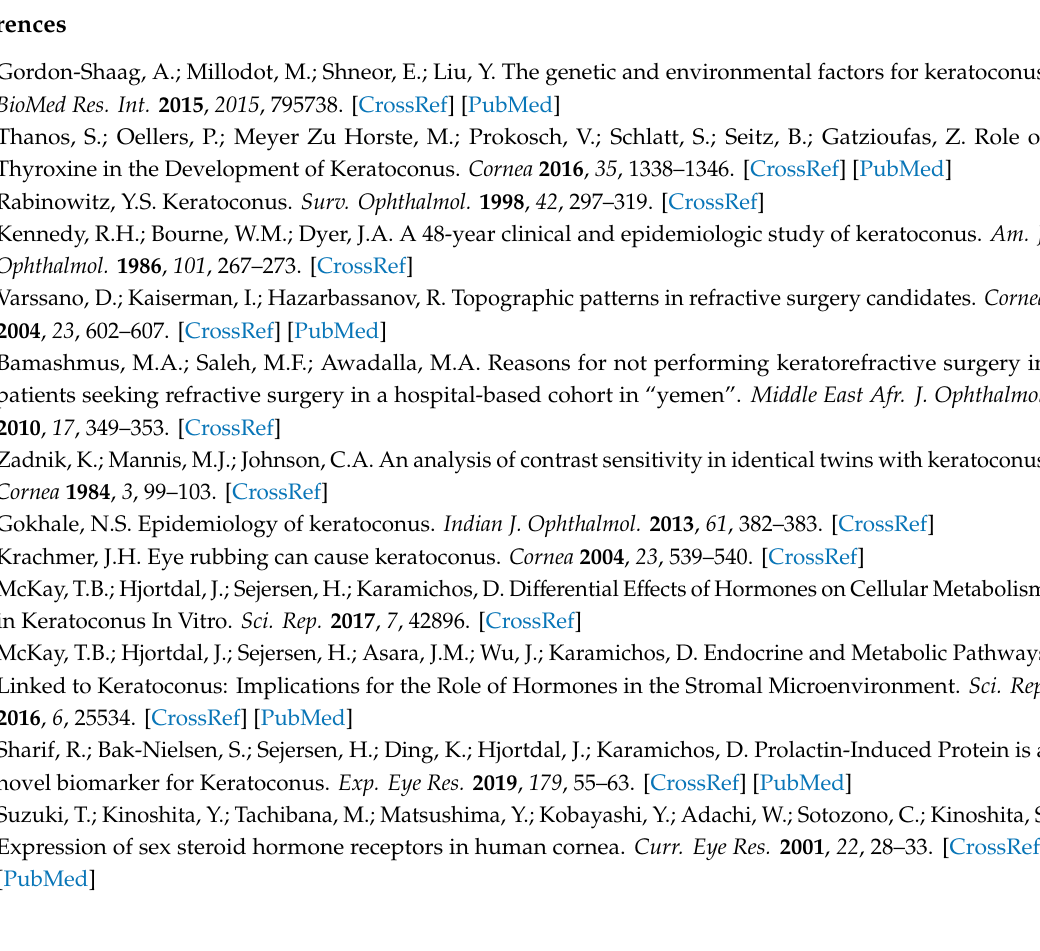
s1, Figure S1: Overall LH / FSH expression, Figure S2: Gender-dependent LH / FSH expression, Figure S3: Age-dependent LH / FSH expression, Figure S4: Age e ff ect as a function of gender expression of LH / FSH, Figure S5: Severity-dependent LH / FSH expression, Figure S6: Treatment-dependent LH / FSH expression, Figure S7: HCF / HKC-Protein expression of LH, LHR, FSHR, and β -actin, Figure S8: HCEC-Protein expression of FSHR and β